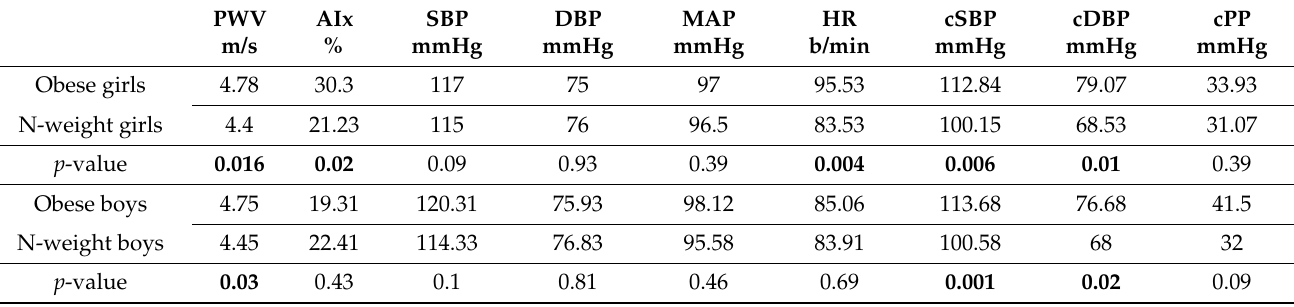
Table 5. PWA comparison for the same sexes.